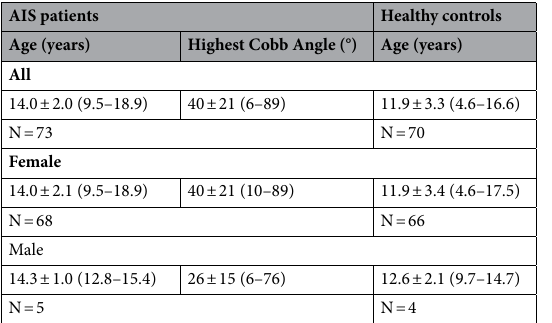
Table 1. Clinical and demographic characteristics of participants in the discovery cohort.